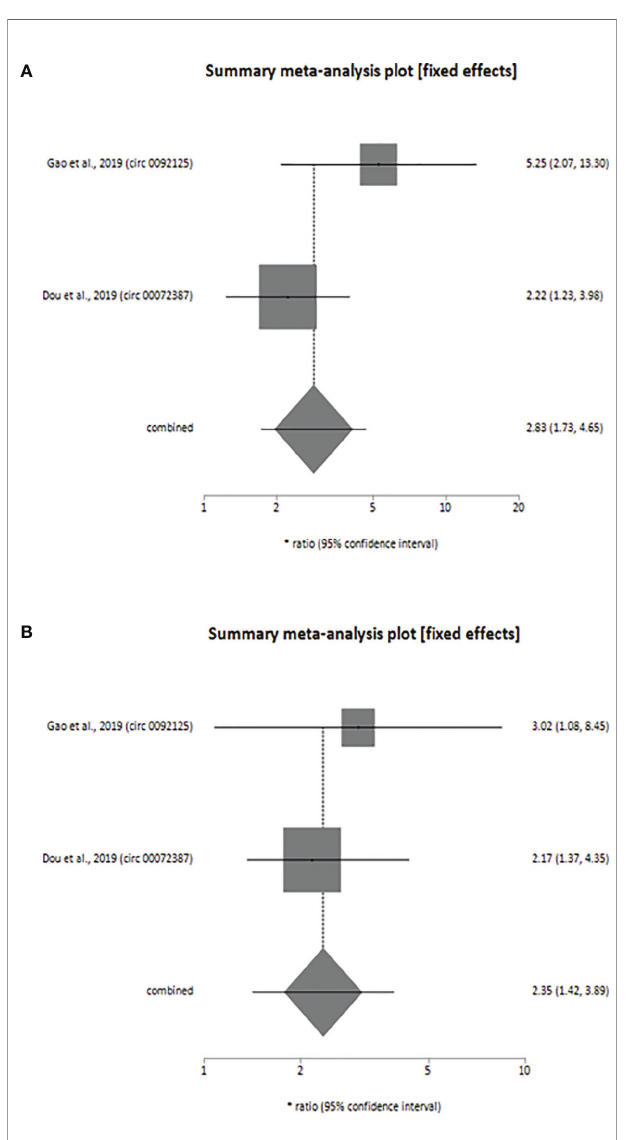
FIGURE 3 | Forest plot showing the combined HR along with individual HR values at 95% CI for the downregulated circRNA pro fi les in predicting the overall survival of patients with HNSCC (A) univariate analysis, (B) multivariate analysis. Square shapes indicate the effect size of each upregulated circRNA pro fi le, while diamond shapes indicate the overall effect size. The 95% CI of each effect sizes are indicated by respective